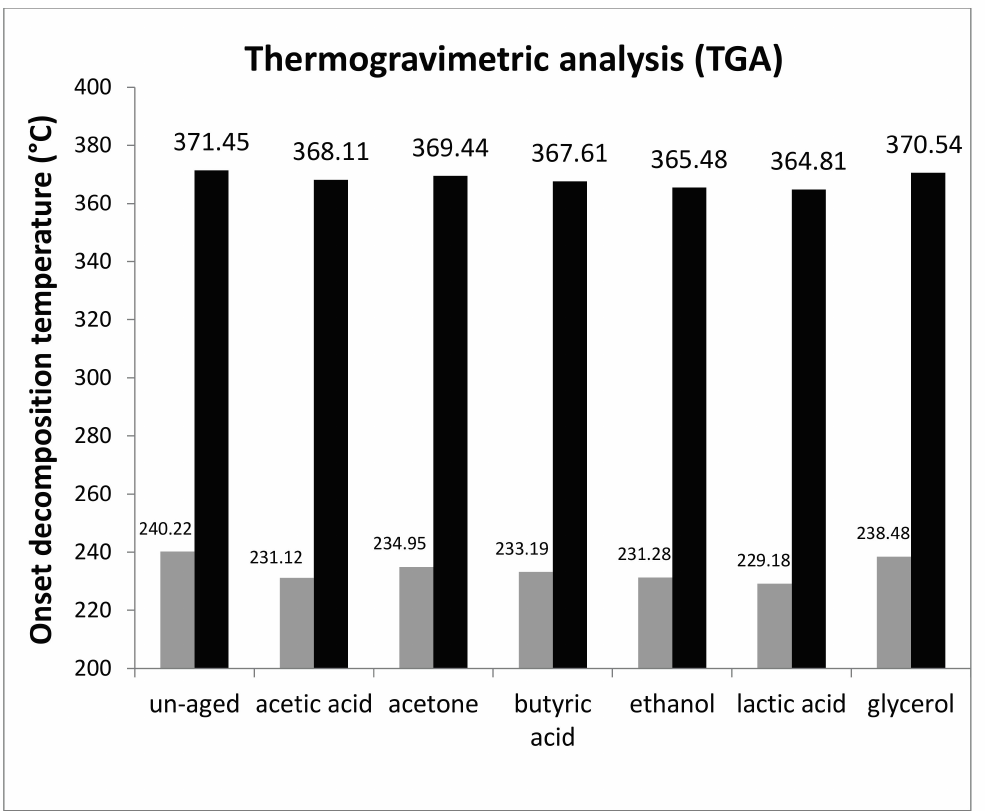
Figure 2. Comparative onset decomposition temperatures for polyvinyl chloride (PVC) coated-fabric (PVCCF) and APCCF samples in different conditions (un-aged: before the ageing test, the rest are corresponding to ageing the samples in various mediums). The dark-black corresponds to ‘before ageing’ and the grey columns correspond to the ‘aged